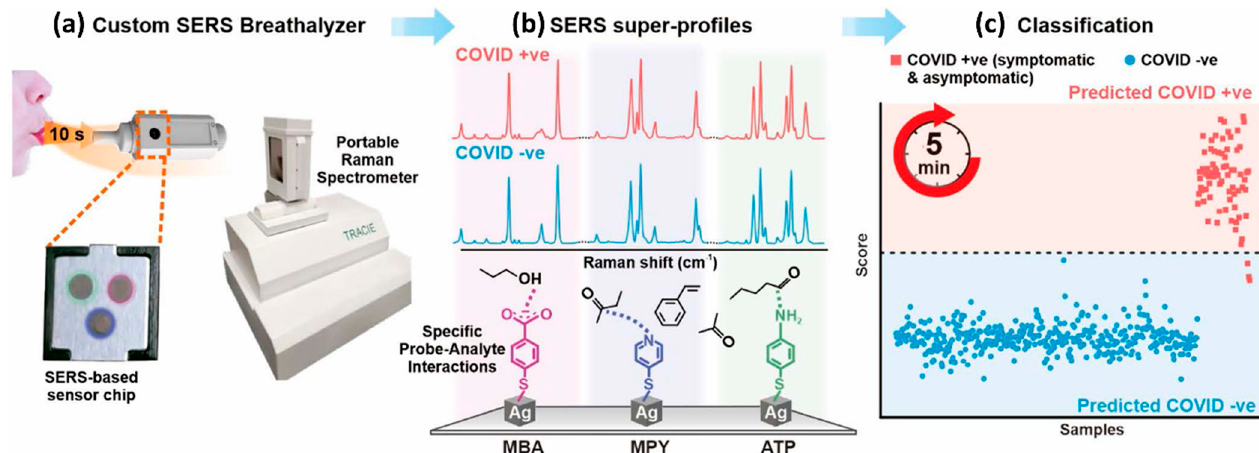
Figure 10. A flow-diagram of the SERS-based method for detecting COVID-positive patients utilizing volatile organic molecules in their breath (BVOCs). Reproduced with permission from ref. [131]. Copyright 2022 American Chemical Society.